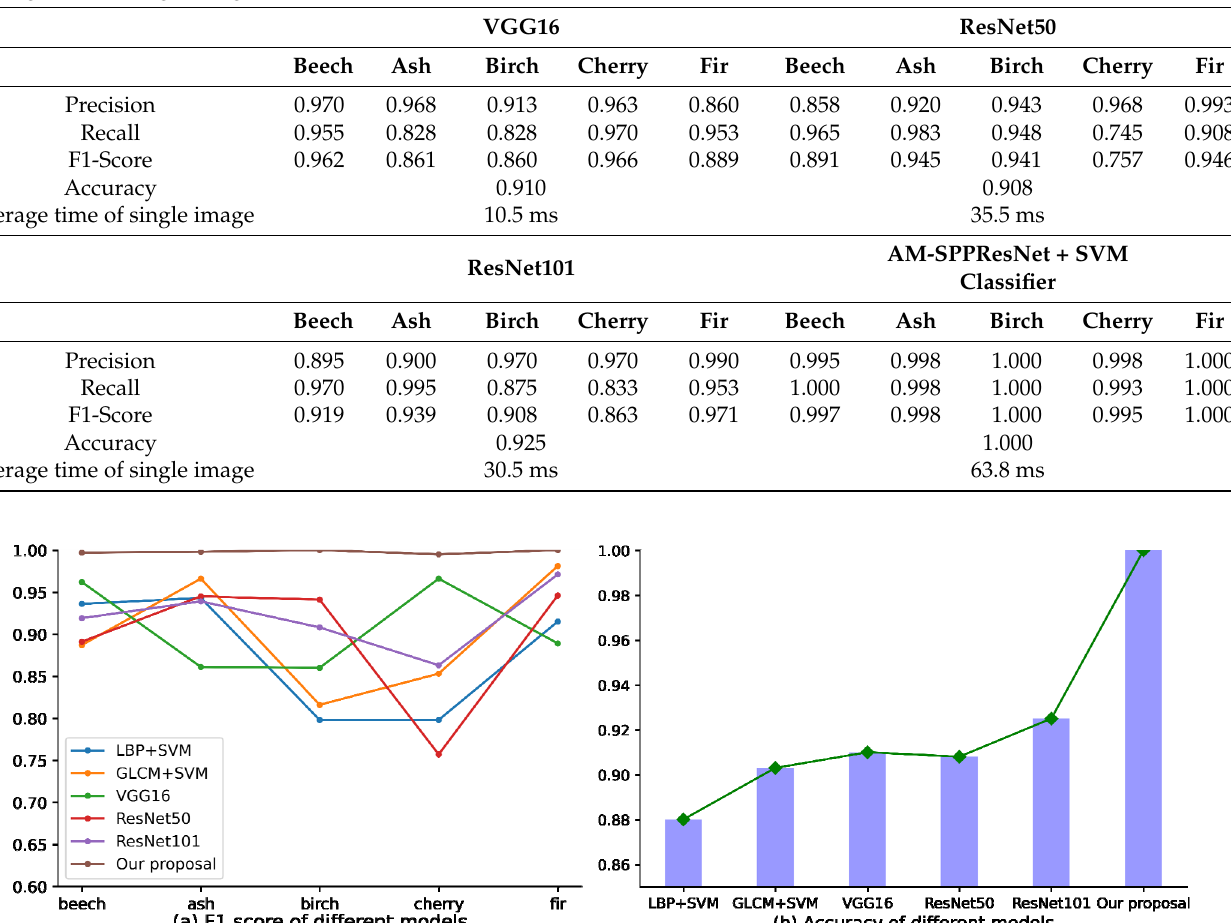
Table 5. Prediction matrix of different models applied in identification of sawn timber tree species.